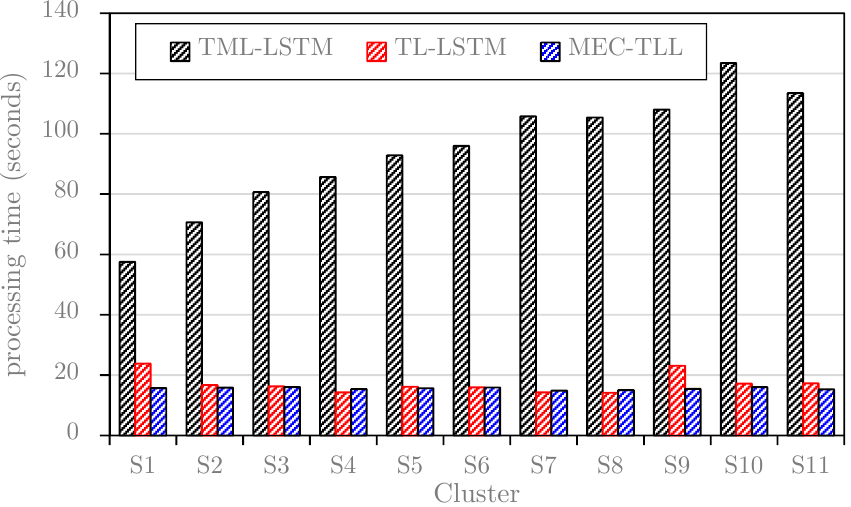
Figure 9. The computational time of each cluster on the B1 dataset.